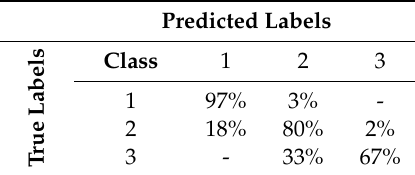
Table 6. Confusion matrix for the model of impact (M I